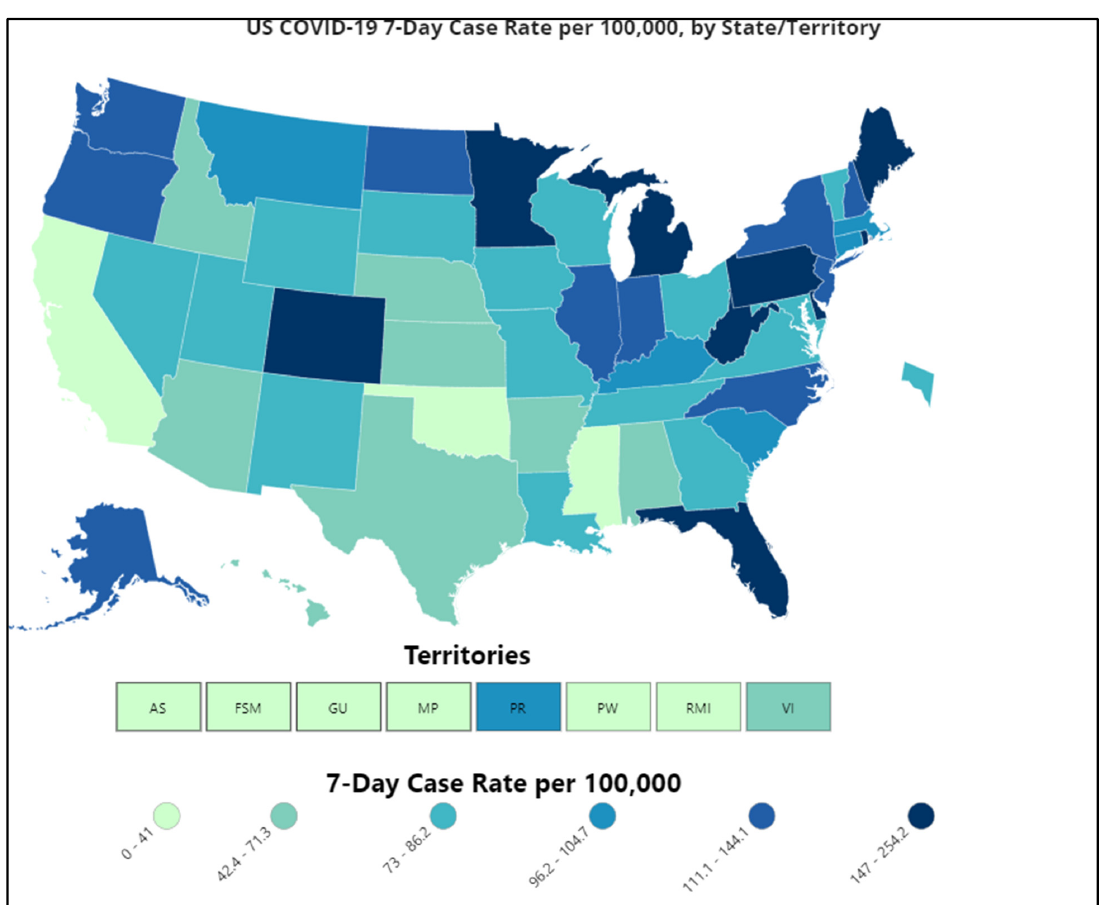
Figure 4. COVID-19 Case Rate in the U.S. Reported to the CDC, by State/Territory (cases per 100,000) (Source: Reproduced from the CDC) [4].